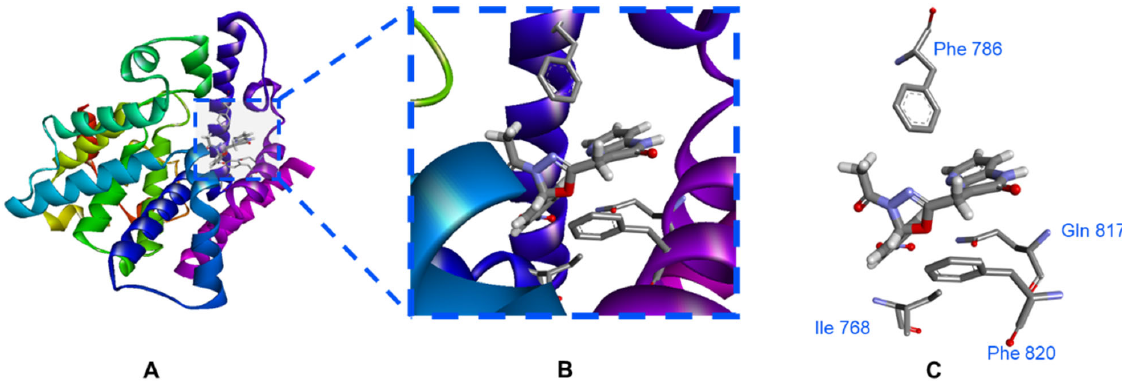
Figure 9. The expected binding interaction between the most active compound ( 11b ) and PDE5 protein (PDB ID: 3HC8). ( A ) the 3D conformation of PDE5 protein with the allocated compound 11b in the active site; ( B ) the condensed view of the PDE5 active site showed the key amino acid residues and their close distance to compound 11b binding motifs (pyridopyrazinone scaffold and terminal aryl group); ( C ) the isolated view of PDE5 active site showed compound 11b with significant interactions with the key amino acid residues in the PDE5 active site (Phe 768, hydrophobic interaction with terminal phenyl ring; Phe 786, hydrophobic interaction with pyridopyrazinone ring; Gln 817, HB interaction with 4-NO 2 group; and Phe 820, hydrophobic interactions with both central oxadiazole ring and pyridopyrazinone ring).